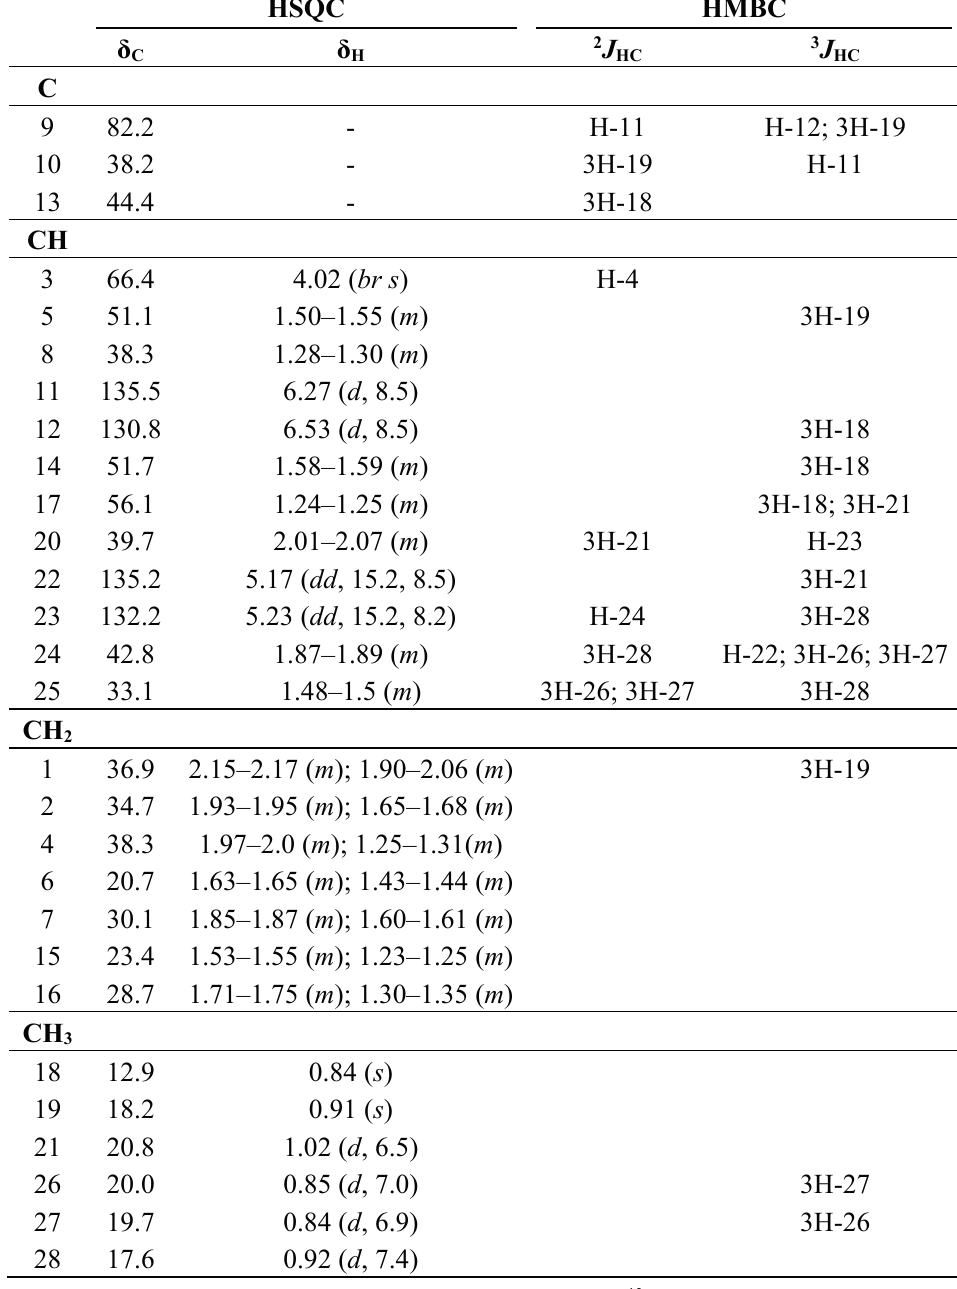
Table 1. 1 H- (500 MHz) and 13 C- (125 MHz) NMR of rauianodoxy ( 6 ), including results obtained by heteronuclear 2D shift-correlated HSQC and HMBC, in CDCl 3 as solvent and TMS used as internal reference. Chemical shifts ( δ , ppm) and coupling constants ( J , Hz, in